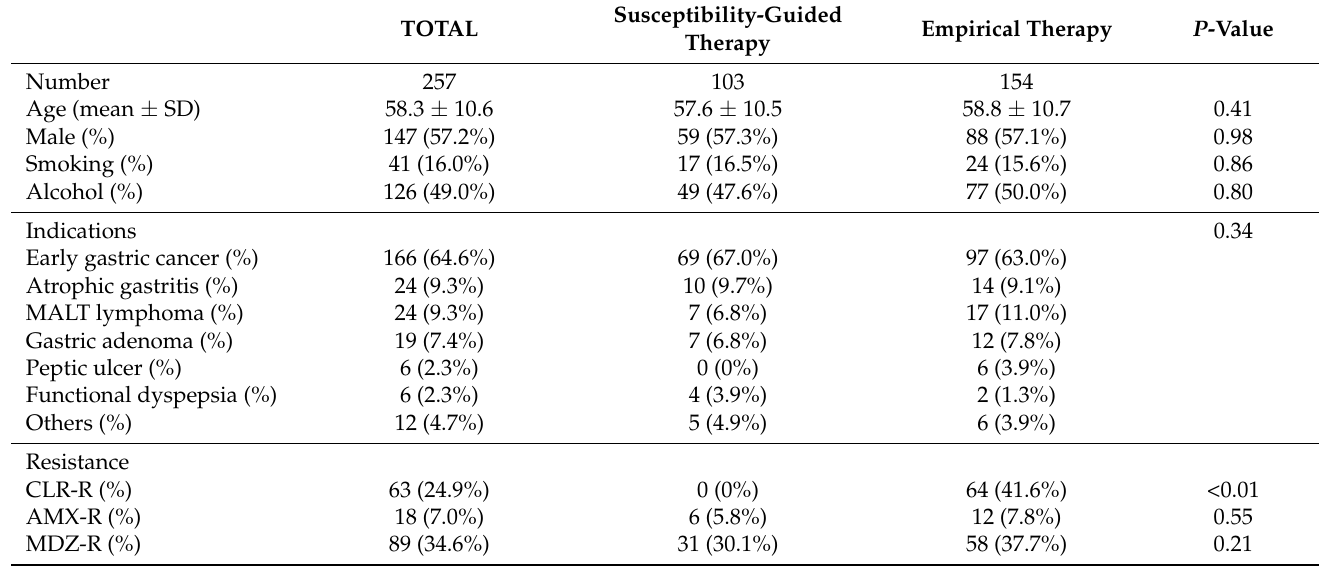
Table 1. Clinical